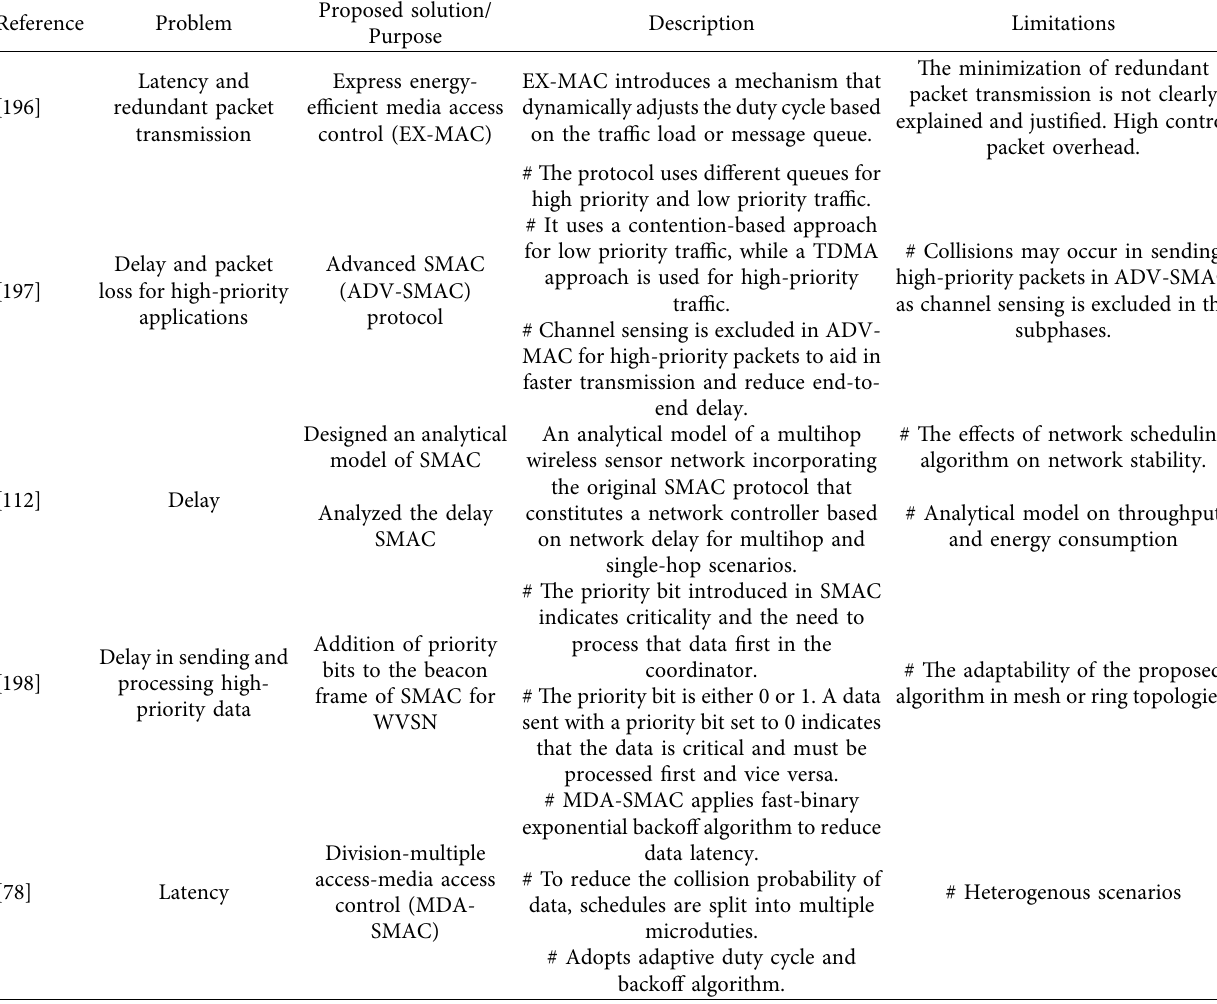
Table 7: Enhanced protocols/algorithms for increased end-to-end delay/latency and packet loss of SMAC protocol. Reference